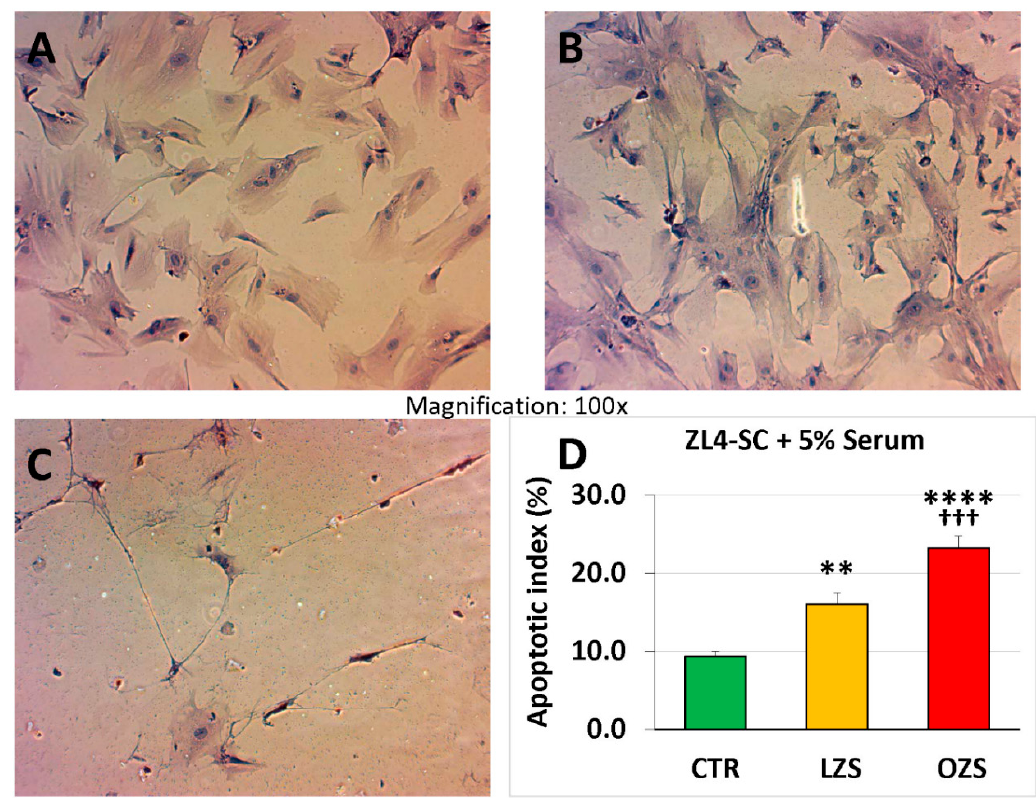
Figure 4. ZL4-SC were more sensitive to apoptosis caused by ZFS than the ZF4-SC shown in Figure 3, but they were also mildly affected by ZLS . ZL4-SC were incubated, as in Figure 1, with no addition ( A ) or added ZLS ( B ) or ZFS ( C ), and then subjected to TUNEL reaction, and pictures were taken at 100 × . ( D ) The bar graph is equivalent to the one in Figure 1 but on a linear scale. C: no serum addition; **** p ≤ 0.0001 (C vs. ZFS); ** p ≤ 0.01 (C vs. ZLS); +++ p ≤ 0.001 (ZFS vs. ZLS).